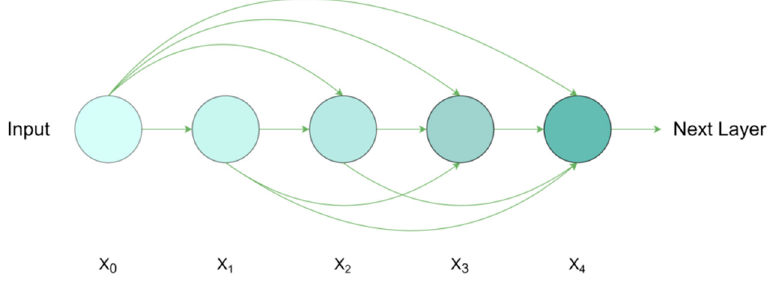
Figure 6. Operation of densely connected convolution, the dense block layer.